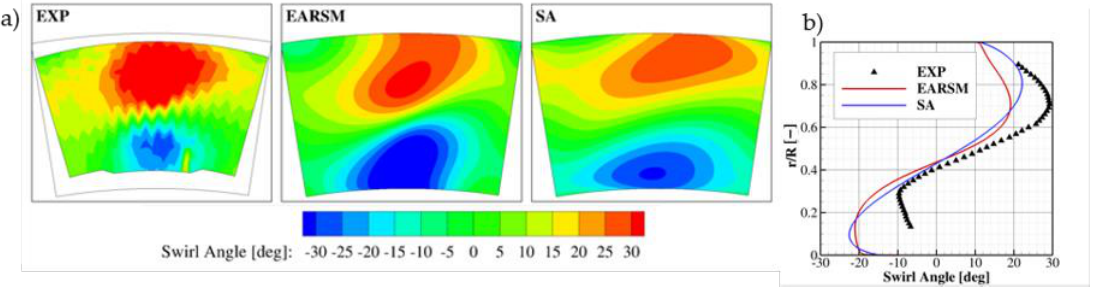
Figure 8. Swirl angle at plane P40: 2D contour ( a ) and circumferentially averaged ( b ).